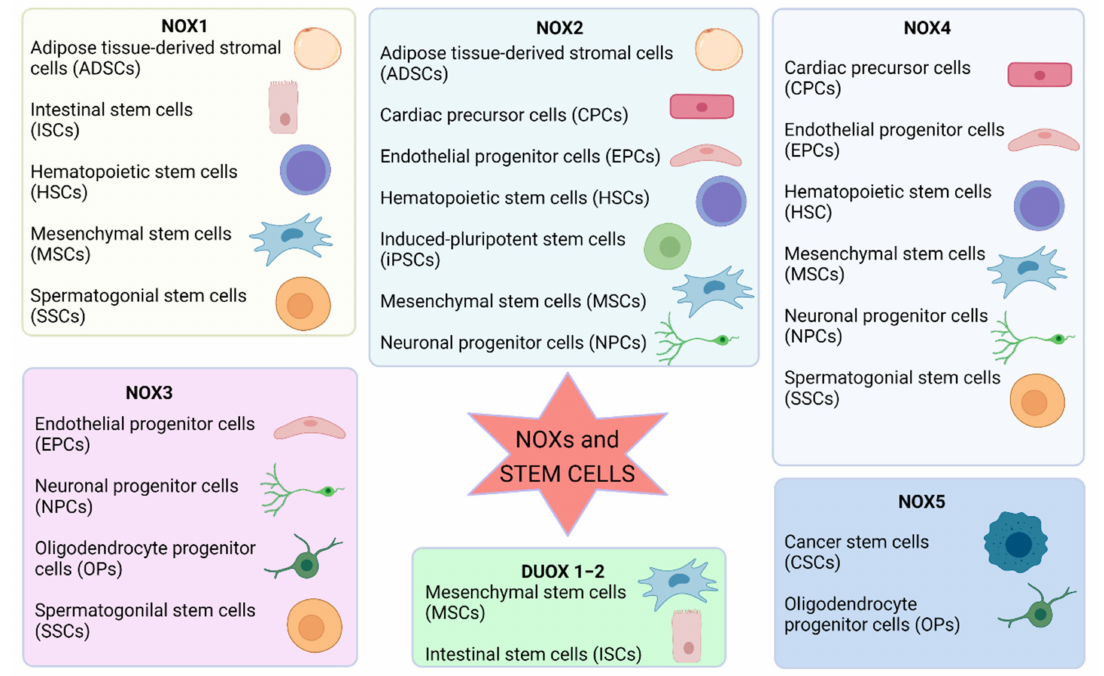
Figure 2. Summary of the involvement of NOX isoforms in different types of stem cells. Image created with BioRender.com (accessed on 1 May